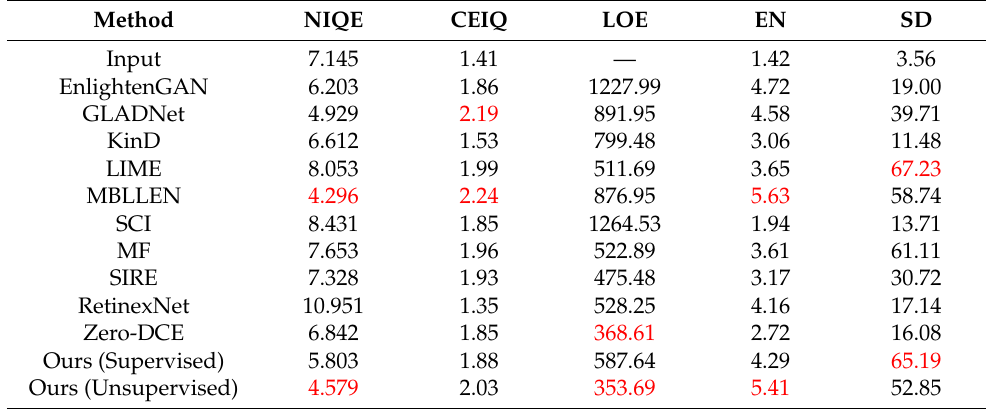
Table 2. Different Image Metrics in Extremely Low-Light